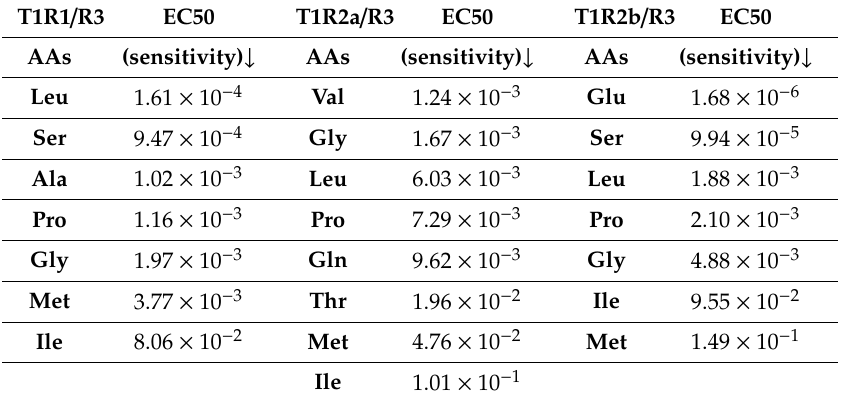
Table 1. Evaluation of saT1R1 / R3 , saT1R2a / R3 and saT1R2b / R3 sensitivity, as deduced from ligand potency parameter EC50, recorded for 11 L-AAs producing a dose-response curve of